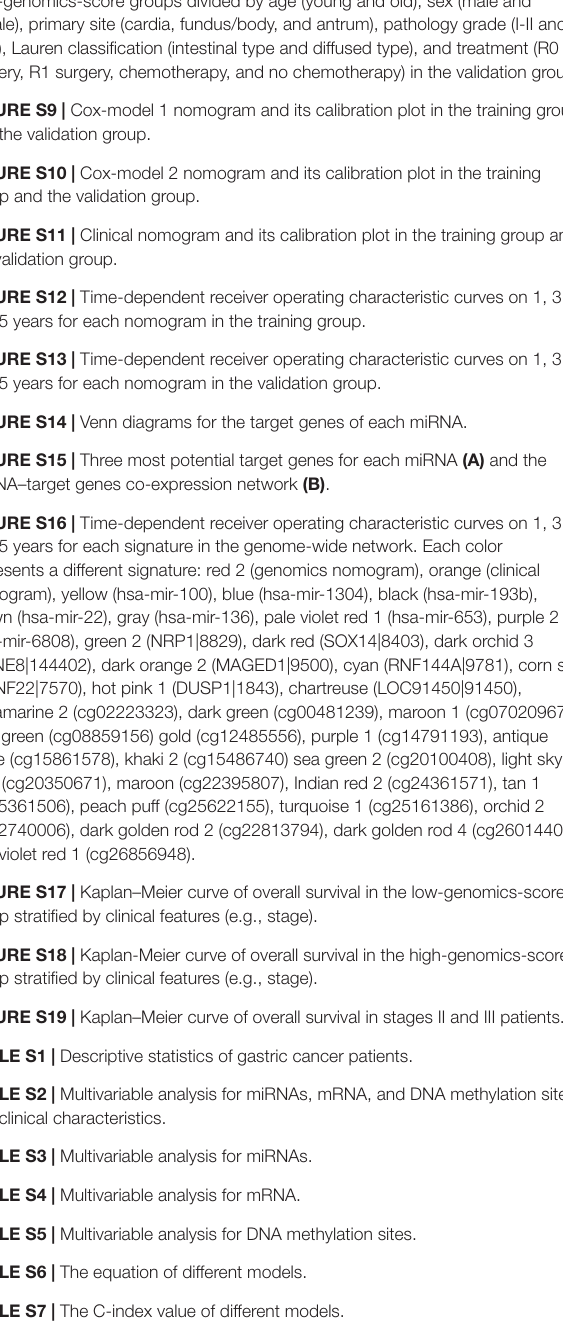
FIGURE S1 | Screening process for the genome-wide network. FIGURE S2 | Screening process for the Gene Ontology analysis and Kyoto Encyclopedia of Genes and Genomes pathways. FIGURE S3 | Least absolute shrinkage and selection operator Cox regression performed for miRNAs, mRNA, and DNA methylation sites. FIGURE S4 | A heat map based on genomic scores layered by clinicopathological factors. FIGURE S5 | Median survival for patients in the low-genomics score (GS) and the high-GS groups.